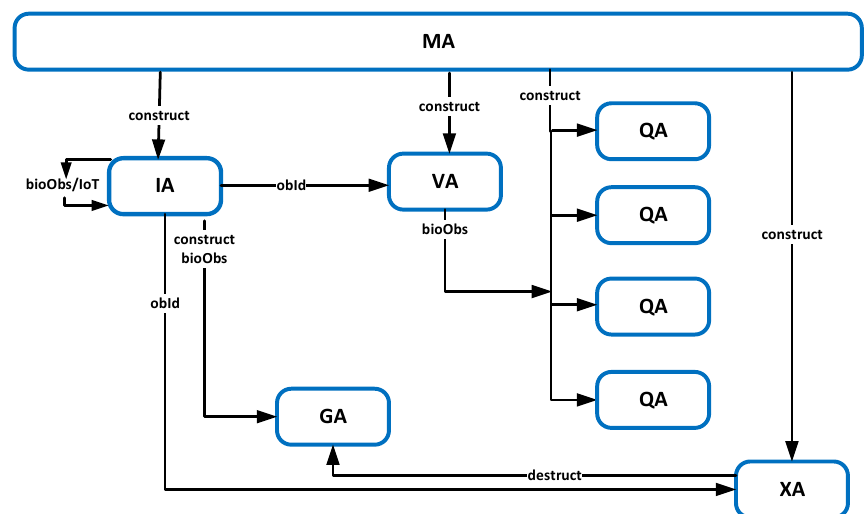
Figure 9. Basic data flows in the system. (Only single instance of GA process is